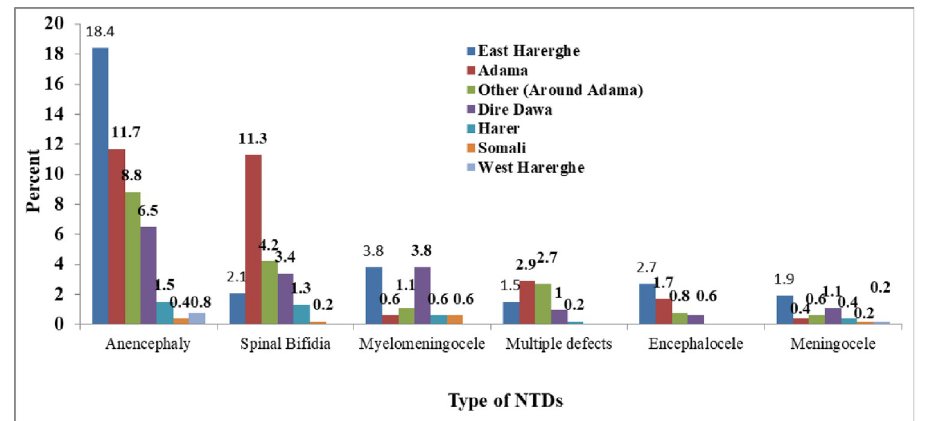
Fig 6. Distribution of NTDs among study hospitals Eastern Ethiopia, data from 2017–2019.